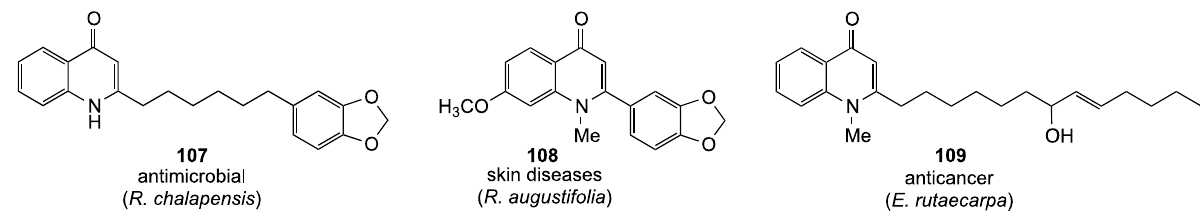
Figure 4. Natural products incorporating 4( 1H